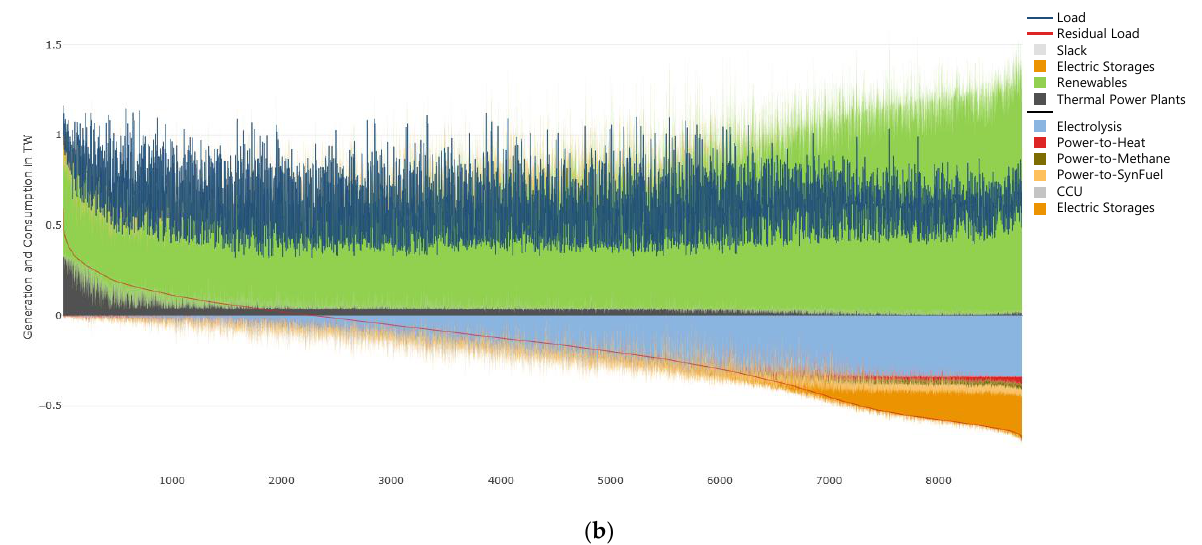
Figure 9. Hourly European energy balance for electricity ordered by the annual residual load for: ( a ) the year 2020; ( b ) the year 2050. Electricity generation is plotted on the positive x-axis, while consumption is plotted in the negative x-axis.